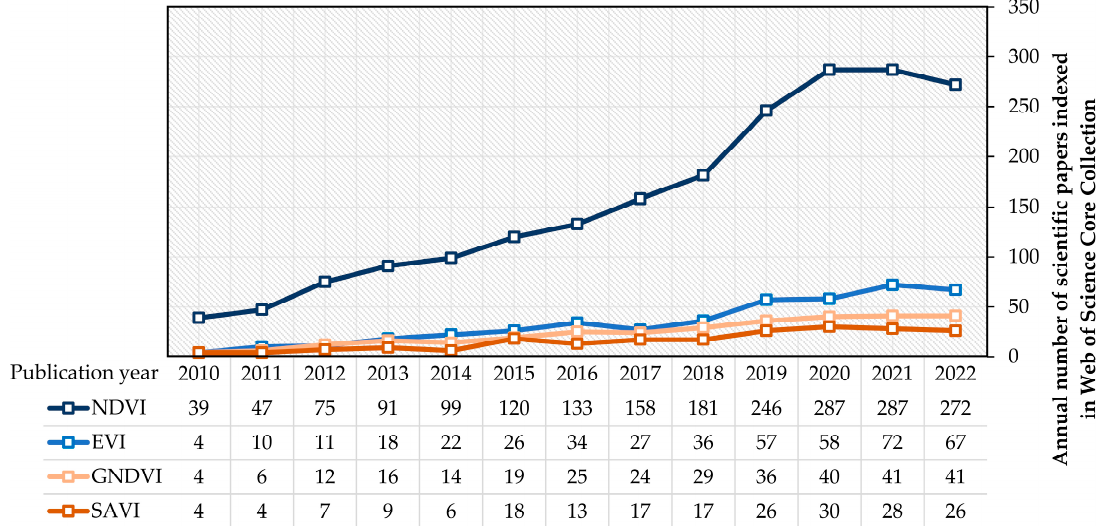
Figure 7. The number of scientific papers indexed in WoSCC since 2010 with the topic of “precision agriculture” AND individual major index based on multispectral sensors. Similar to the case of major vegetation indices based on multispectral sensors, the normalized green–red difference index (NGRDI) has been the predominantly used index of the available indices based on RGB sensors during the past decade, based on the scien- tific papers indexed in WoSCC with the topic of “precision agriculture” and vegetation indices based on RGB sensors (Table 2). The NGRDI provides a low-cost solution to re- place NDVI using the RGB sensors, allowing a similar degree of sensitivity to changes in chlorophyll content in plants by replacing near-infrared with green reflectance [82]. While the NGRDI can be a useful index for detecting early signs of crop stress or disease [83], the NDVI provides a more comprehensive assessment of vegetation health and produc- tivity. Since NGRDI is primarily sensitive to chlorophyll content in plants [84], while the NDVI is sensitive to the amount of vegetation present, including leaves, stems, and branches, its application in precision agriculture is less obstructed than areas with more heterogeneous vegetation, such as forestry [85]. However, the NGRDI has been shown to have low variability across different crop types, while the NDVI can vary significantly depending on the type of vegetation being measured [86]. Many authors supported the claim that vegetation indices based on multispectral sensors enable superior performance in precision agriculture to indices based on RGB sensors [24], while the latter are still an adequate low-cost alternative [87]. The United States (20 papers) and China (15 papers) accounted for the majority of scientific papers which utilized NGRDI in precision agricul- ture, out of which 34 papers matched the additional topic query of “yield”, having a sim- ilar percentage of total papers as NDVI. Their application was particularly focused on the UAVs, having 33 papers (45.8% of total papers), compared to satellite missions with 25 papers (34.7% of total papers).